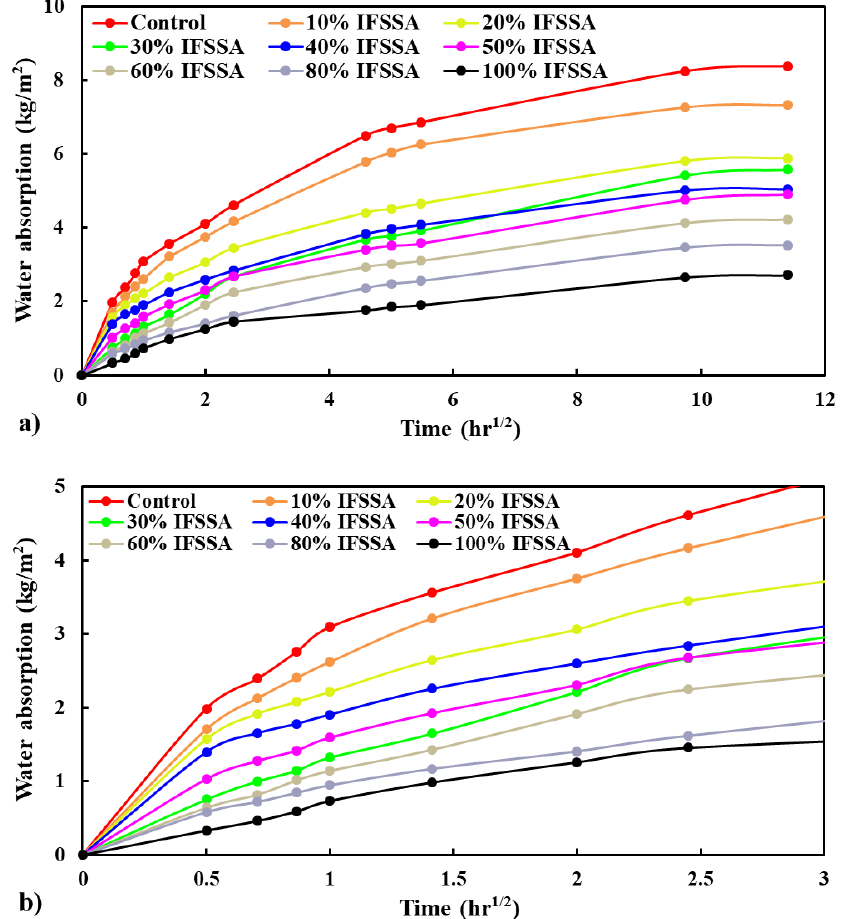
Figure 12. Capillary water absorption ( a ) and detail in data near the origin to represent the slope of the curves ( b ) of concrete specimens made with different percentages of IFSSA.